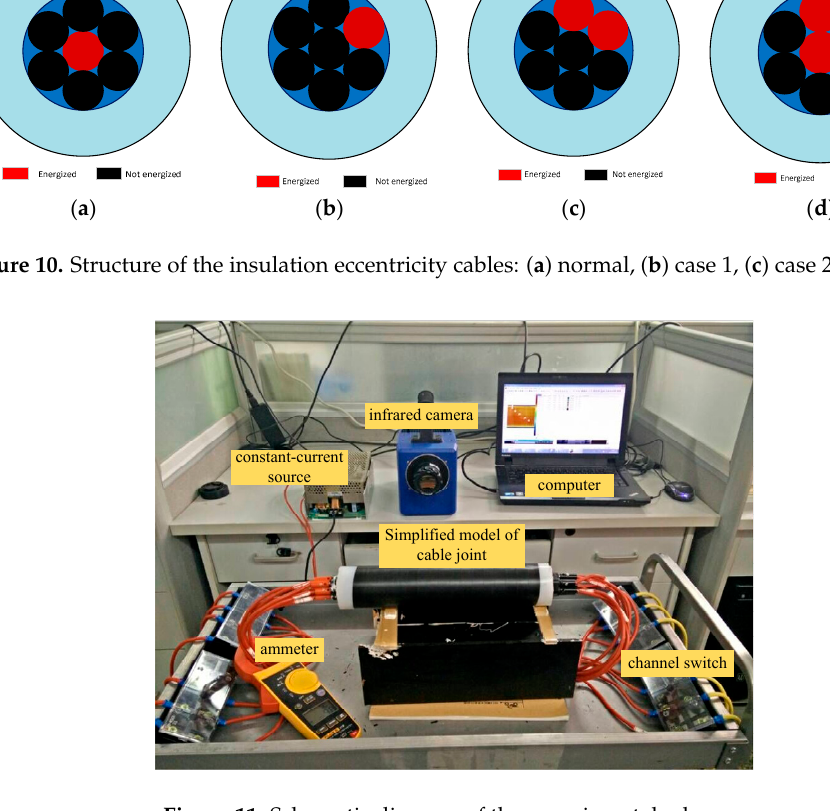
Figure 12. Infrared images of cable surface temperature: ( a ) normal, ( b ) case 1, ( c ) case 2, ( d ) case 3.